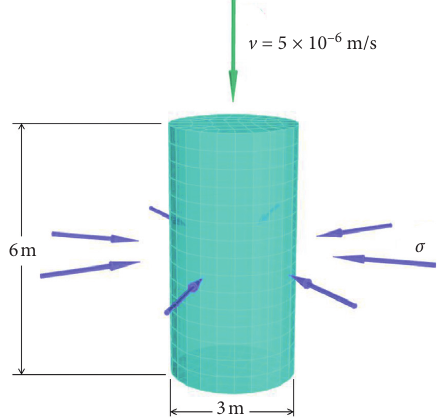
Figure 7: Schematic diagram of the numerical specimen model.